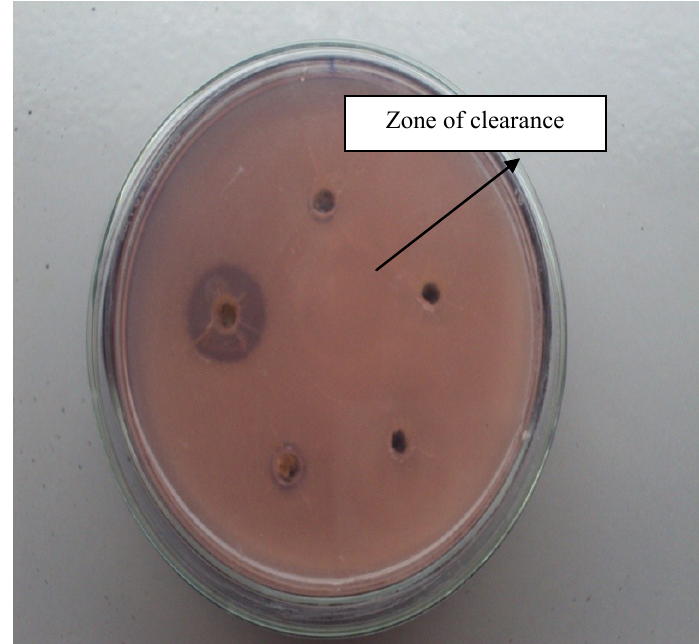
Figure 2. Zone of clearance produced by action of